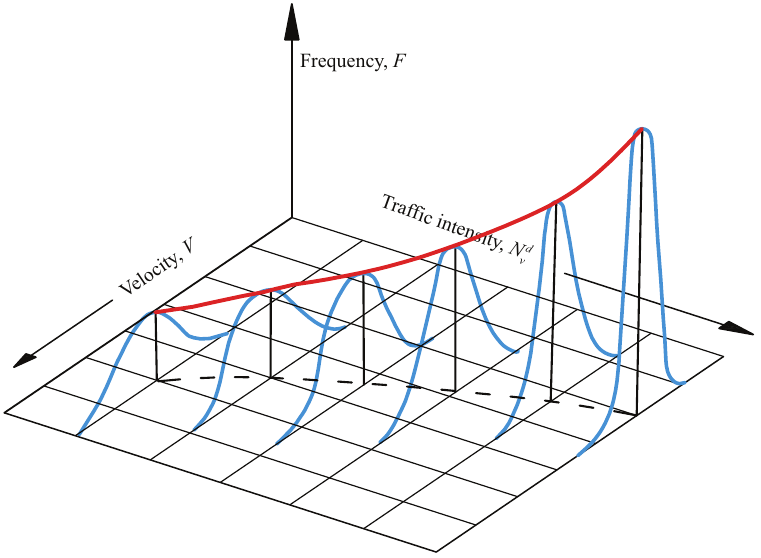
Figure 6. Speed distribution curves at various traffic volumes (Walker,